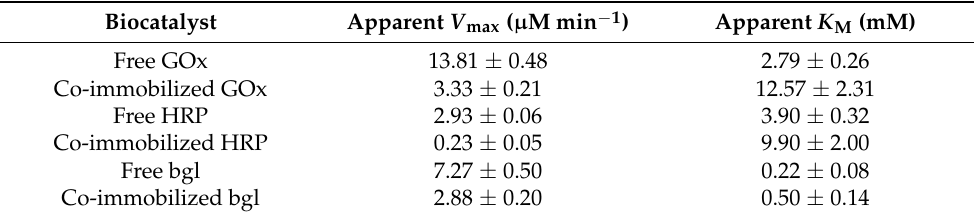
Table 2. Apparent kinetic constants of free, individually immobilized, and co-immobilized form of GOx, HRP, and